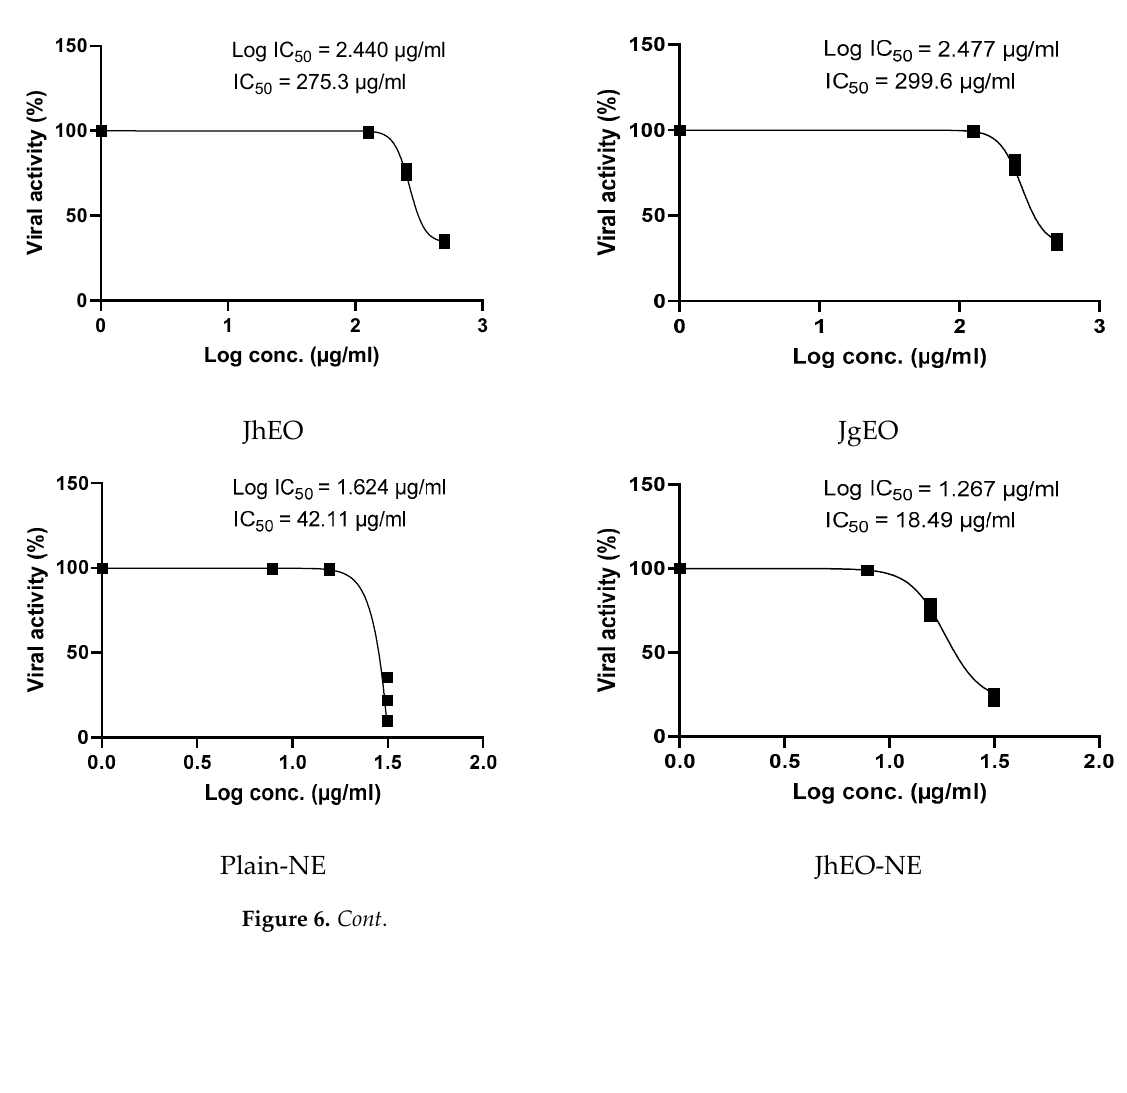
Figure 5. IC 50 of J. humile (JhEO) and J. grandiflorum (JgEO) pure essential oils, their nanoemulsion formulations (JhEO-NE) and (JgEO-NE), plain nanoemulsion formulation (Plain-NE) as well as standard acyclovir against HAV virus.